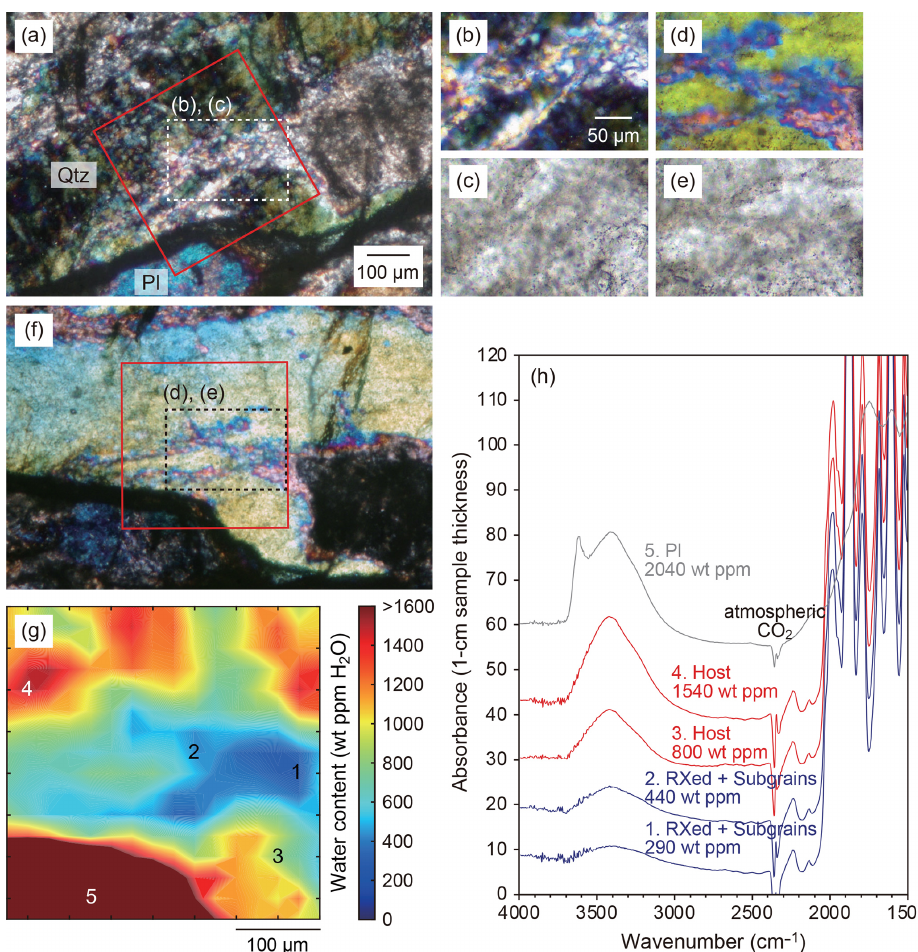
Figure 8. IR mapping results for the weakly deformed sample. The sample thickness is 97µm. (a) Optical photomicrograph under cross- polarized light. The IR mapped area is shown with a red square. The dashed white rectangle depicts the area of enlarged images of fine- grained quartz regions that include host grains under (b) cross-polarized and (c) plane-polarized light. Similarly, images (d) and (e) are from (f) , where the optical photomicrograph is rotated approximately 30 ◦ clockwise from (a) . Fine-grained quartz regions are smaller than those in (a) , indicating that subgrains are included. (g) Water distribution. Numbers represent raw IR spectra in (h) . Color-coded water contents up to 1600wtppm H 2 O are for quartz, and those above are for plagioclase around no. 5 in (g) . “RXed” in (h) means recrystallized. Both recrystallized grains and subgrains are included in the measured